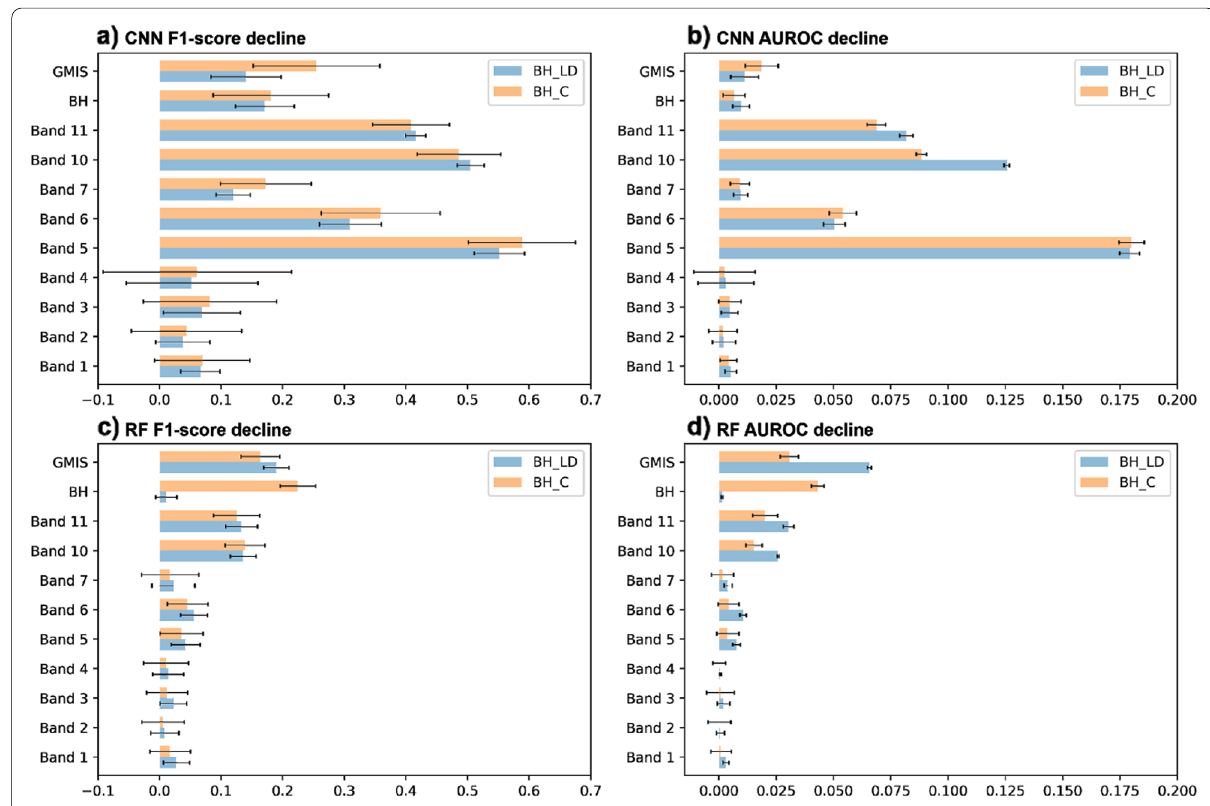
Fig. 17 The F1‑score decline ( a , c ) and AUROC decline ( b , d ) for the CNN ( a , b ) and RF ( c , d ) algorithm from the single‑pass forward permutation test. Orange bars show the average decline from BH_C and blue bars from BH_LH. Error bars denoted the minimum and maximum magnitude of decline from all the 20 cross‑validation